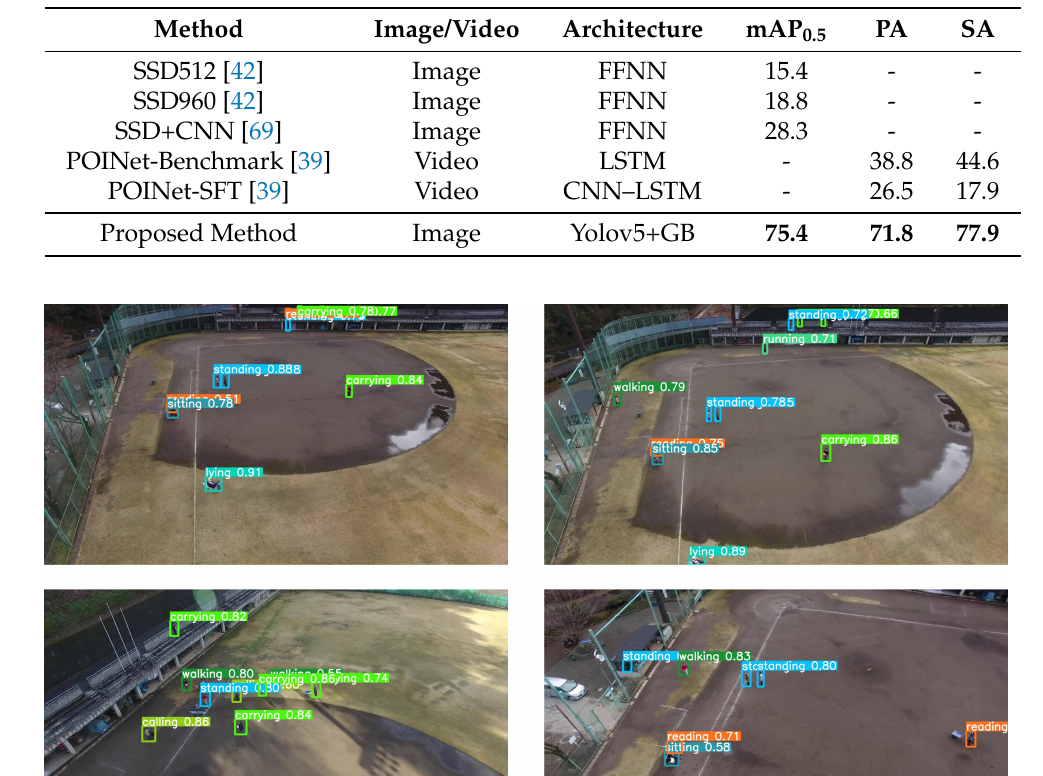
Table 4. Comparison of our proposed method with other state-of-the-art methods for the Okutama- Action dataset. We report the YoloV5x6 as the best performing Yolo architecture. The performance is measured in mean average precision (%) for 50% IoU. PA stands for primary actions, while SA stands for secondary actions. FFNN represents fully-connected feed-forward neural networks, while GB denotes gradient boosting.